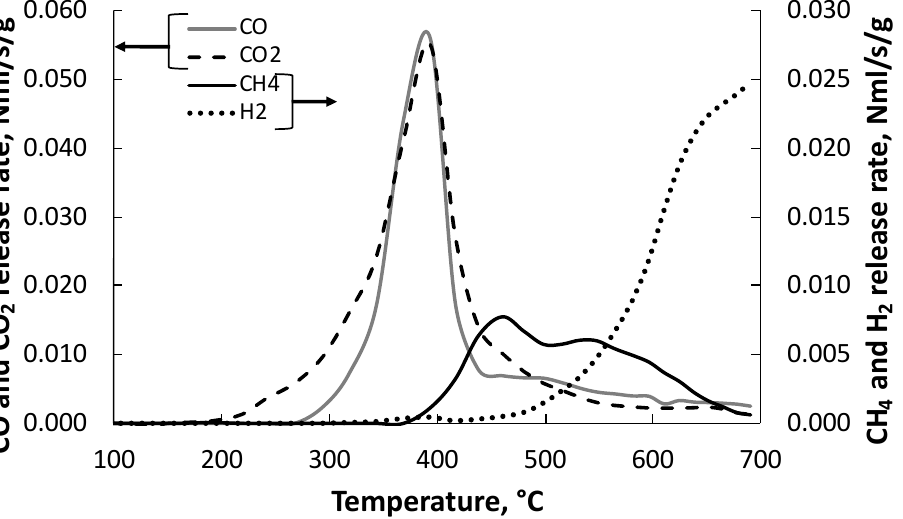
Figure 4. Releasing rate (N mL s − 1 g − 1 LRR on dry basis) of gaseous species from lignin rich residue (LRR) as function of temperature.